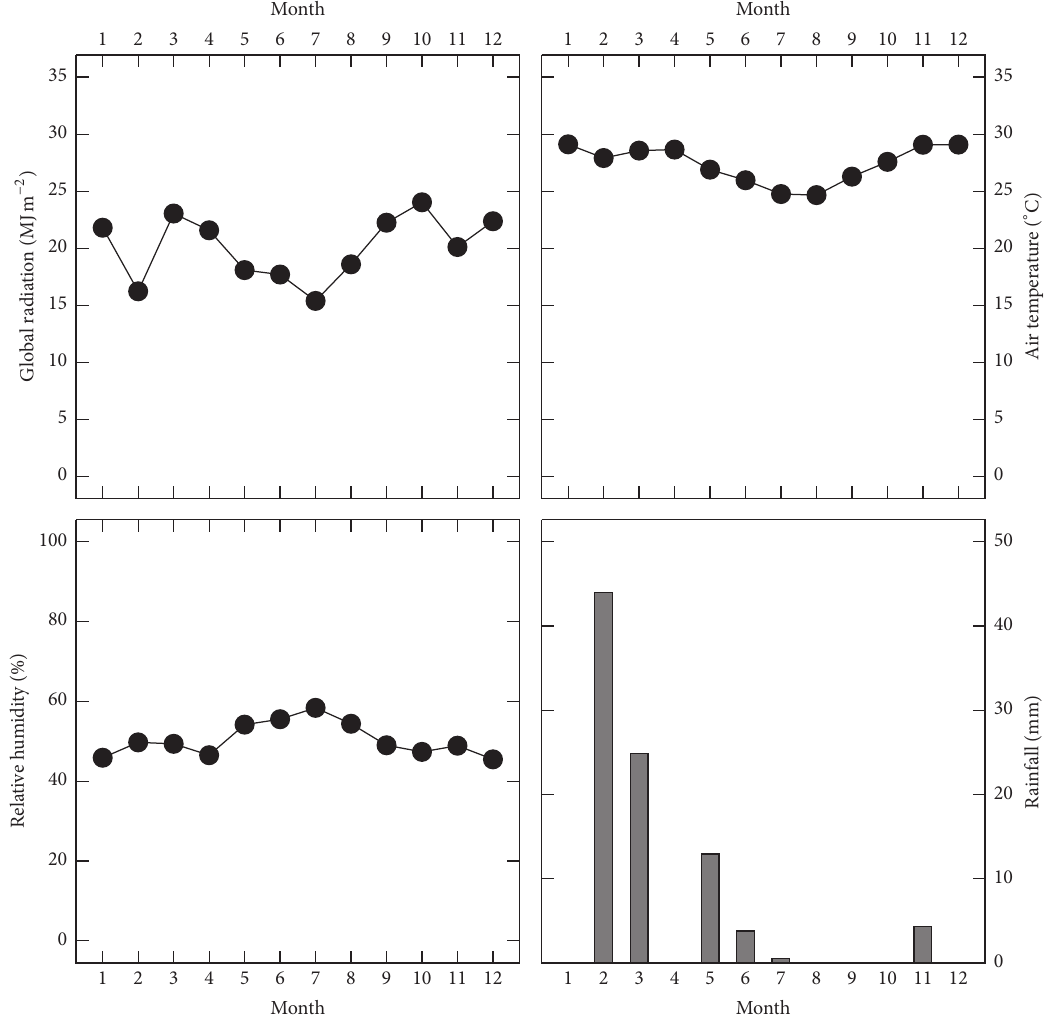
Figure 2: Meteorological scenario for the year of 2012 recorded by the Flux tower installed in an area of Caatinga at Embrapa Semi´arido, which is a research station of the state of Pernambuco, Brazil. Global radiation is the monthly mean of accumulated daily incoming radiations; air, temperature, and relative humidity are presented as monthly mean of the daily mean; and rainfall is the monthly sum of all precipitations.